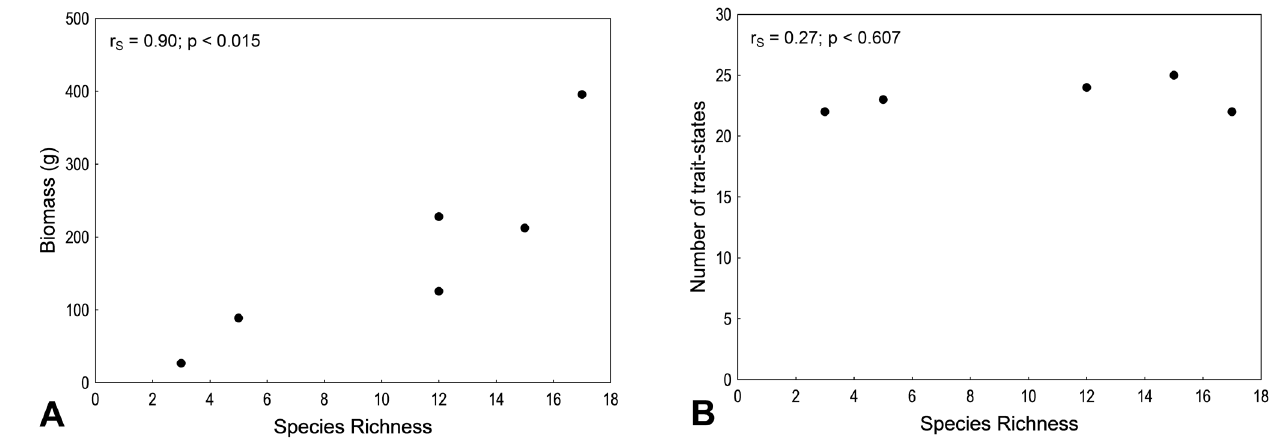
FIGURE 5 | Correlations between species richness and ( A ) total biomass and ( B ) number of ecosystem functions performed by fish populations. The significance of correlations was tested through Spearman's non-parametric